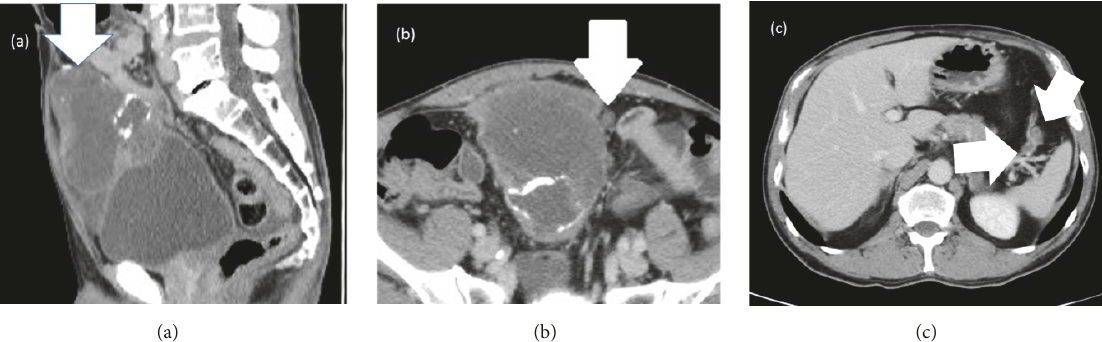
Figure 1: Abdominal computed tomographic image taken before systemic chemotherapy, showing (a) a 9-cm mass extending from the bladder to the umbilicus (white arrow) and ((b) and (c)) intraperitoneal nodules (white arrows).